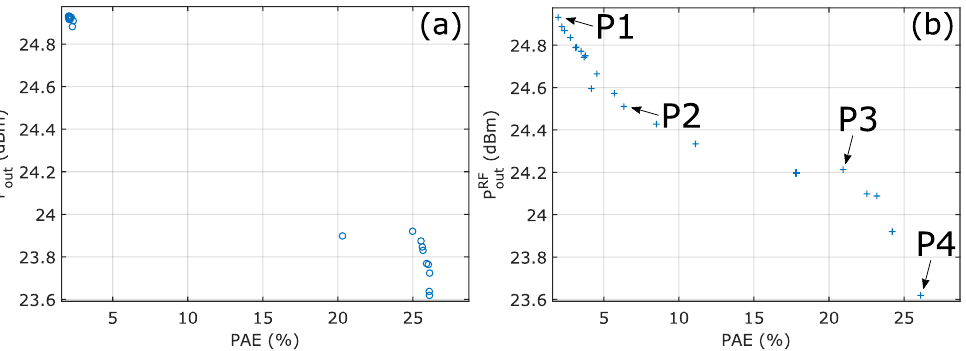
Figure 9. Estimated Pareto frontier between RMS RF output power and PAE obtained with a ( a ) linear combination ( k = 1) and ( b ) non-linear combination ( k = 3), while sweeping the combination factor λ